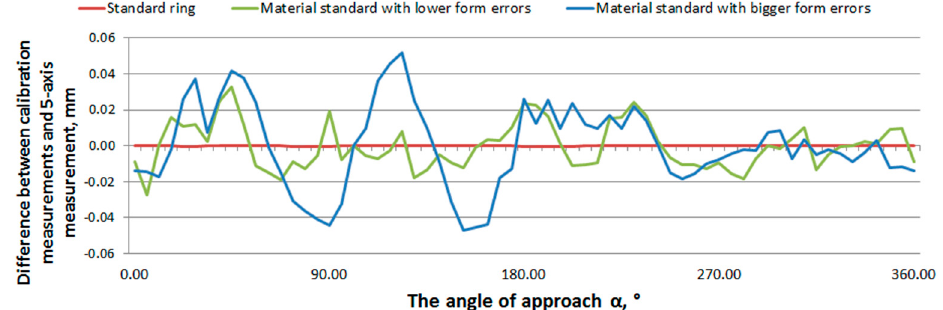
Figure 4. The difference between radial errors obtained for different standards during calibration and five-axis measurements. The radial errors are shown in dependence on changing angle of approach α .